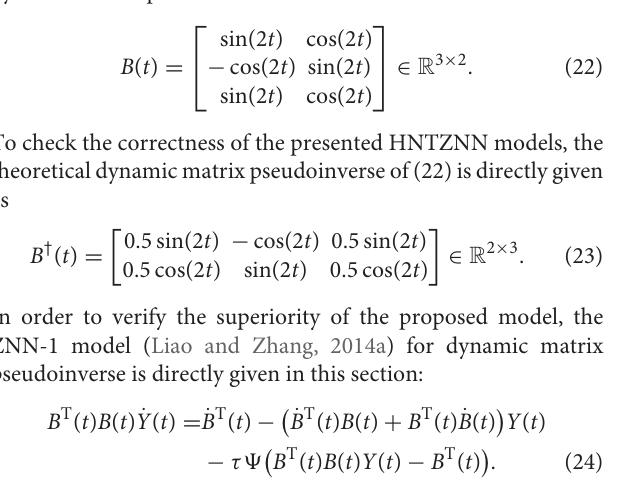
B † ( t ) of (1) when the multiple-harmonic noise is considered,